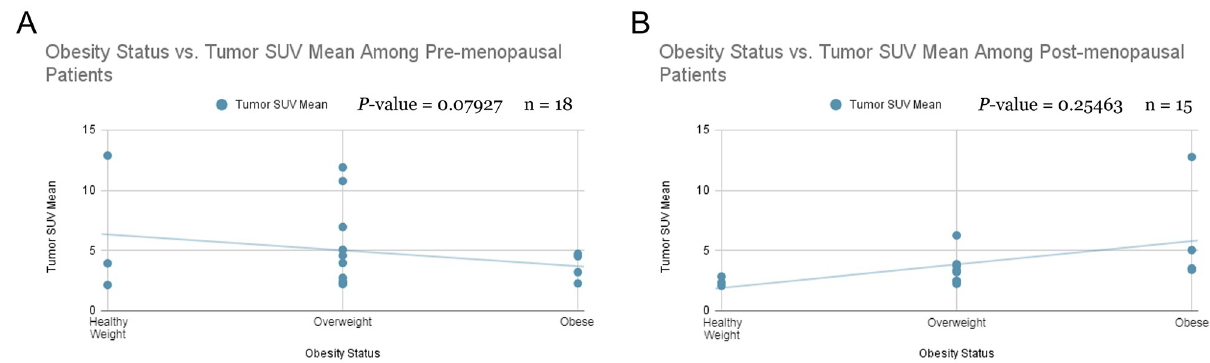
Fig 2. Obesity status vs. lean body mass-corrected thymidine uptake. Correlations between obesity status and lean body mass-corrected thymidine uptake value (SUV mean ) in breast cancer patients separated by (A) pre-menopausal status and (B) post-menopausal status. A two-sided Pearson correlation and Mann-Whitney test was performed, and the corresponding r value determined statistical significance. SUV—standardized uptake value.